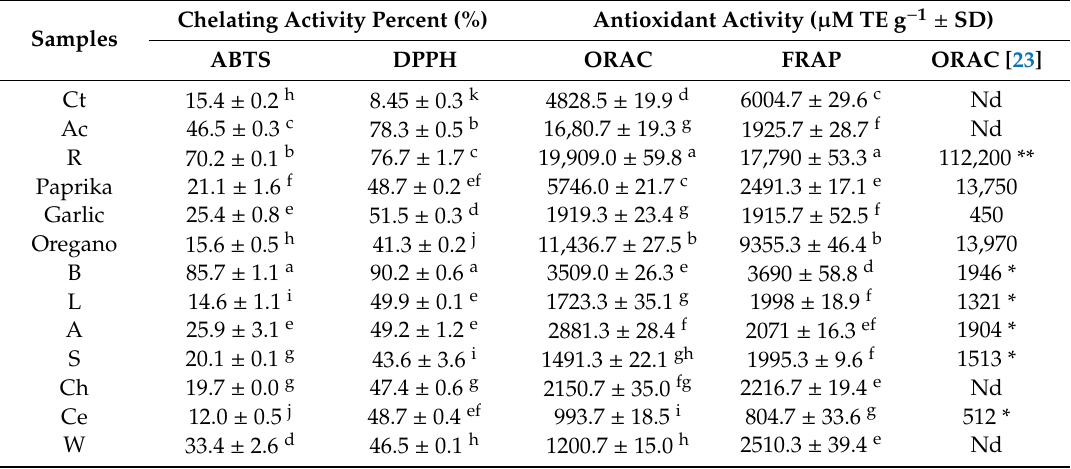
Table 3. Antioxidant activity of natural extracts by measuring their ABTS, and DPPH radical